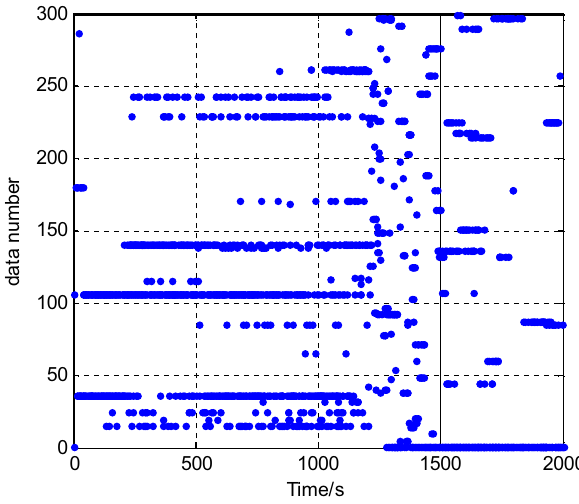
Figure 4: Identi fi cation results of trajectory matching sequence number based on fuzzy relative entropy.